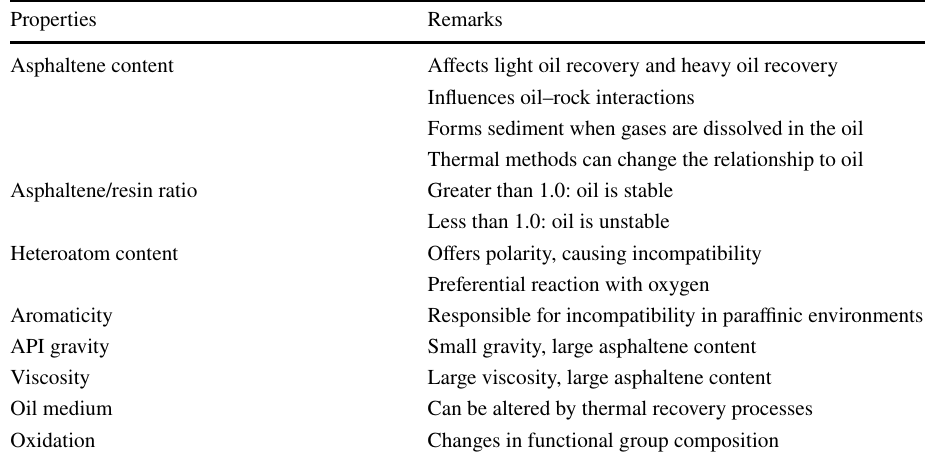
Table 1 The properties of crude oil and their general relationship to sediment formation (Speight 1982)